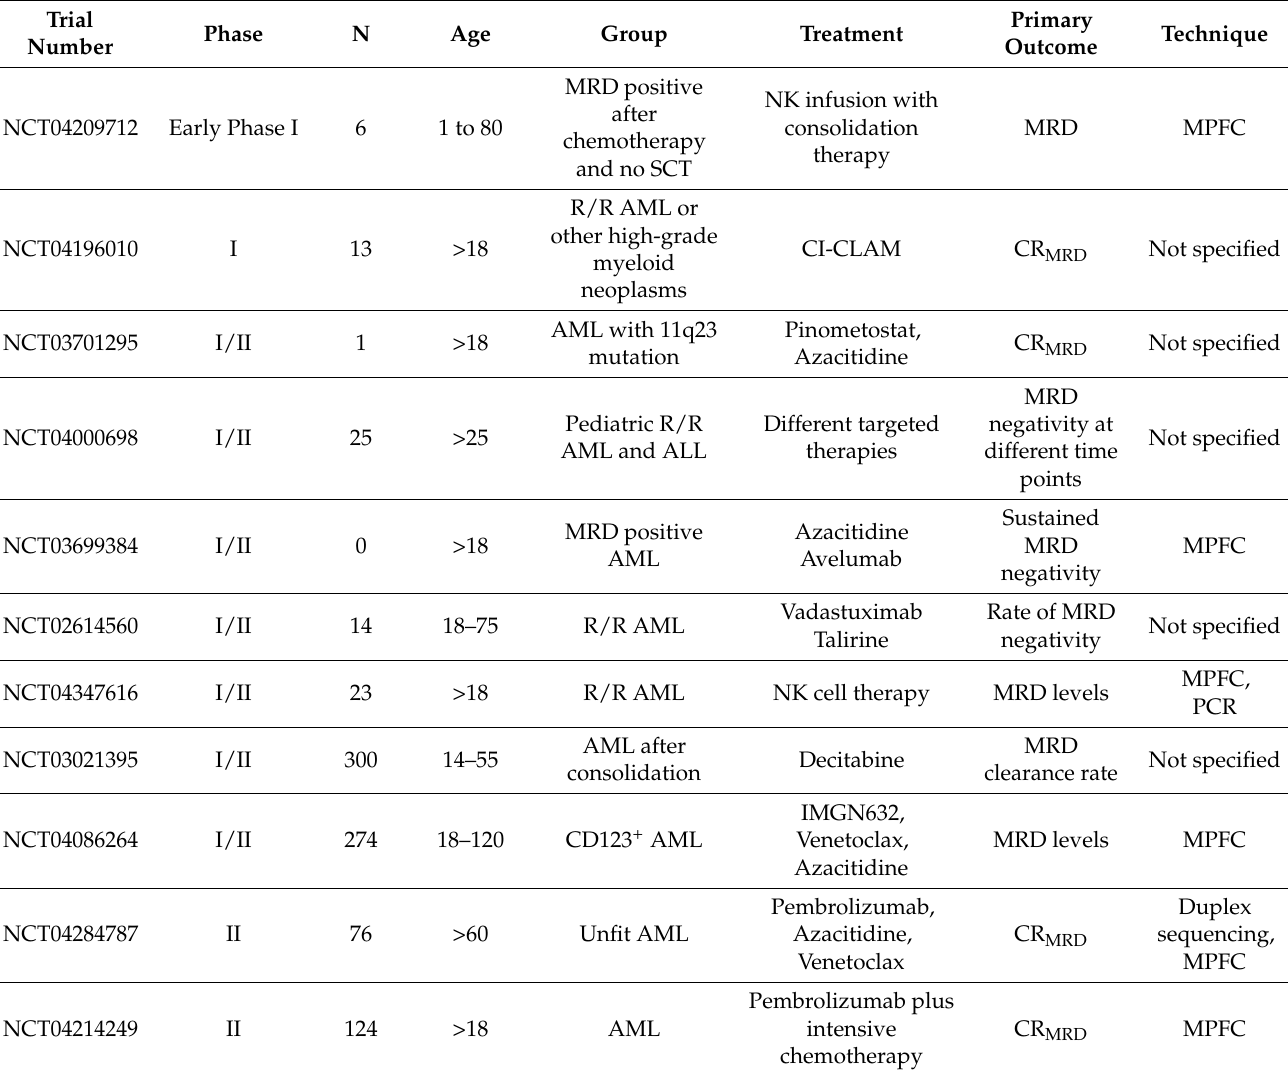
Table 2. Current Trials involving MRD as a primary